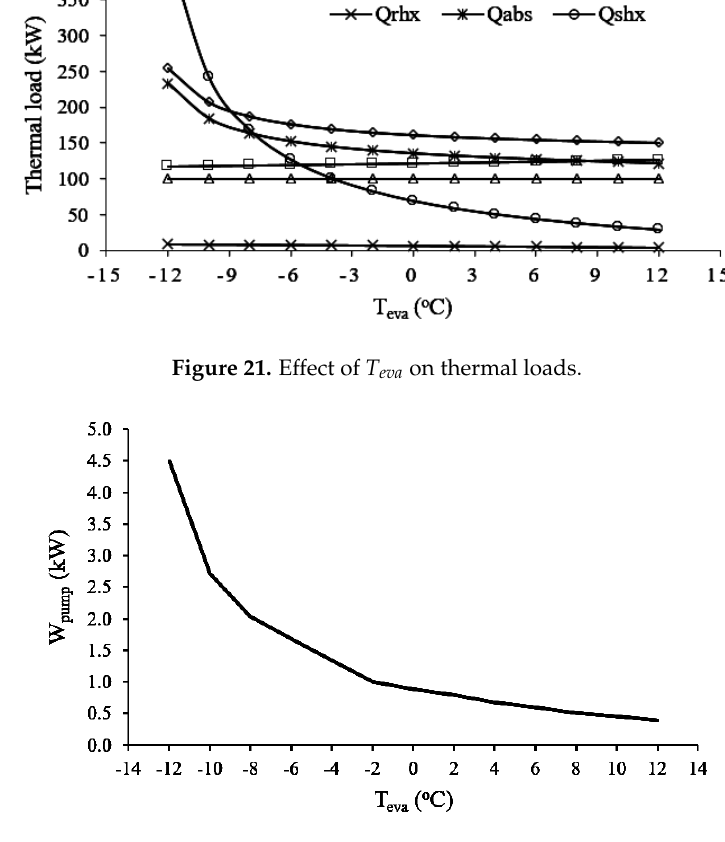
Figure 22. Effect of T eva on pumping power.